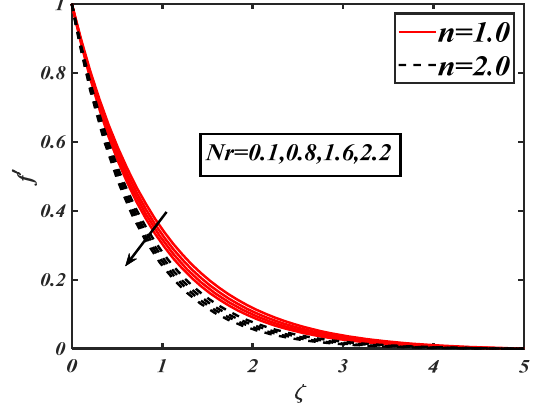
′ ′ . Figure 6. Nr illustration against f (cid:48) . .